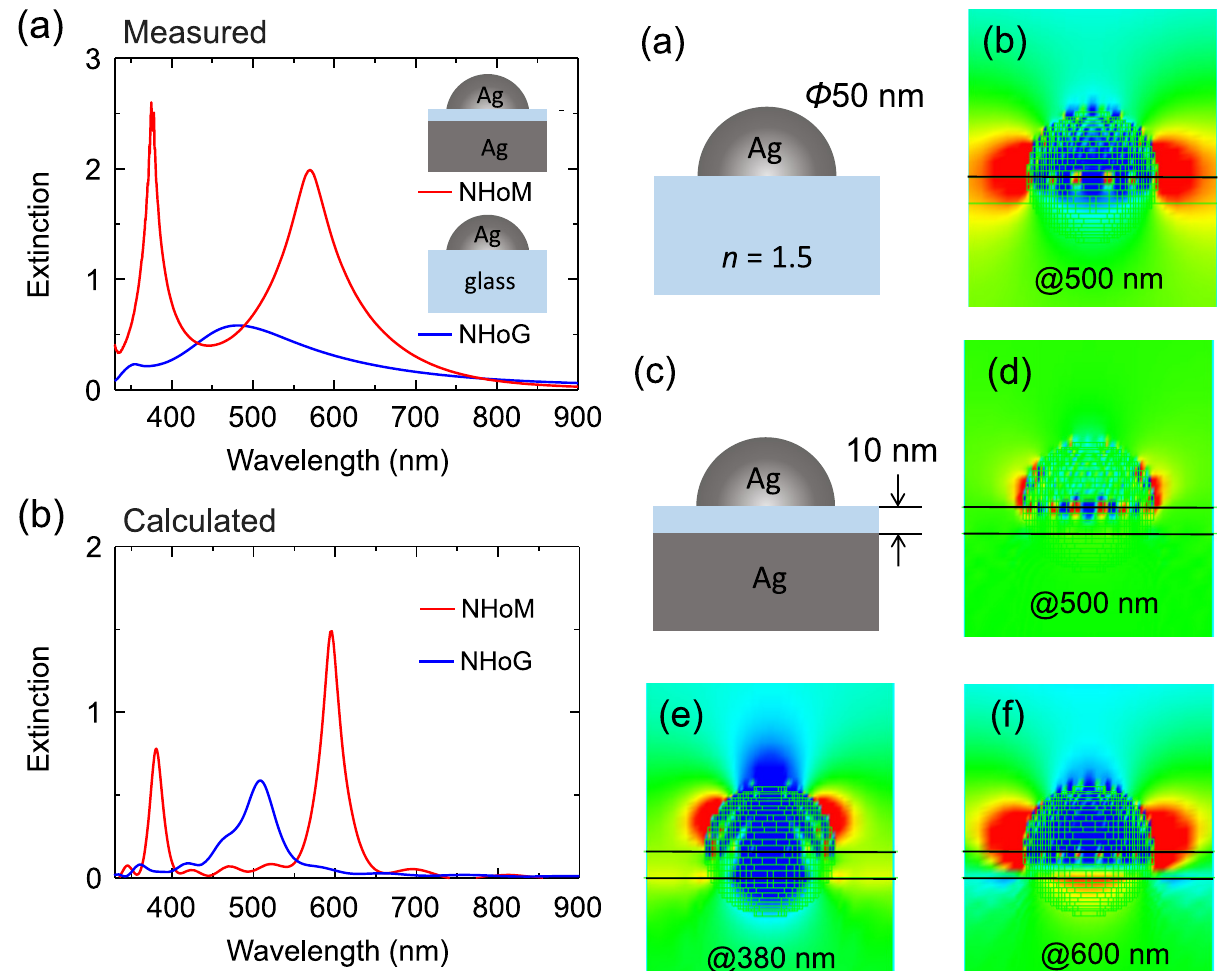
Figure 3: Experimental (a) and calculated (b) results of the extinction spectra of nanohemisphere on glass (NHoG) and the nanohemisphere on mirror (NHoM).